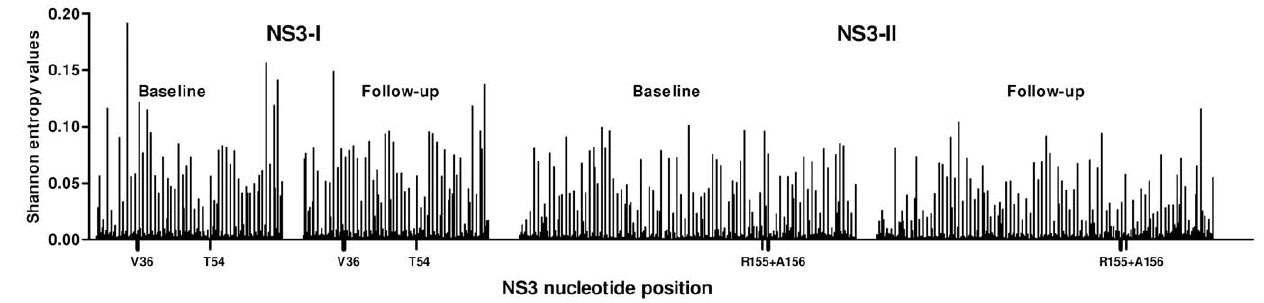
Figure 4. Shannon entropy per nucleotide position at baseline and follow-up. Shannon entropy per nucleotide position (averaged for all patients) is plotted for both amplicons and time points. Resistance associated amino acid positions are indicated on the X-axis.